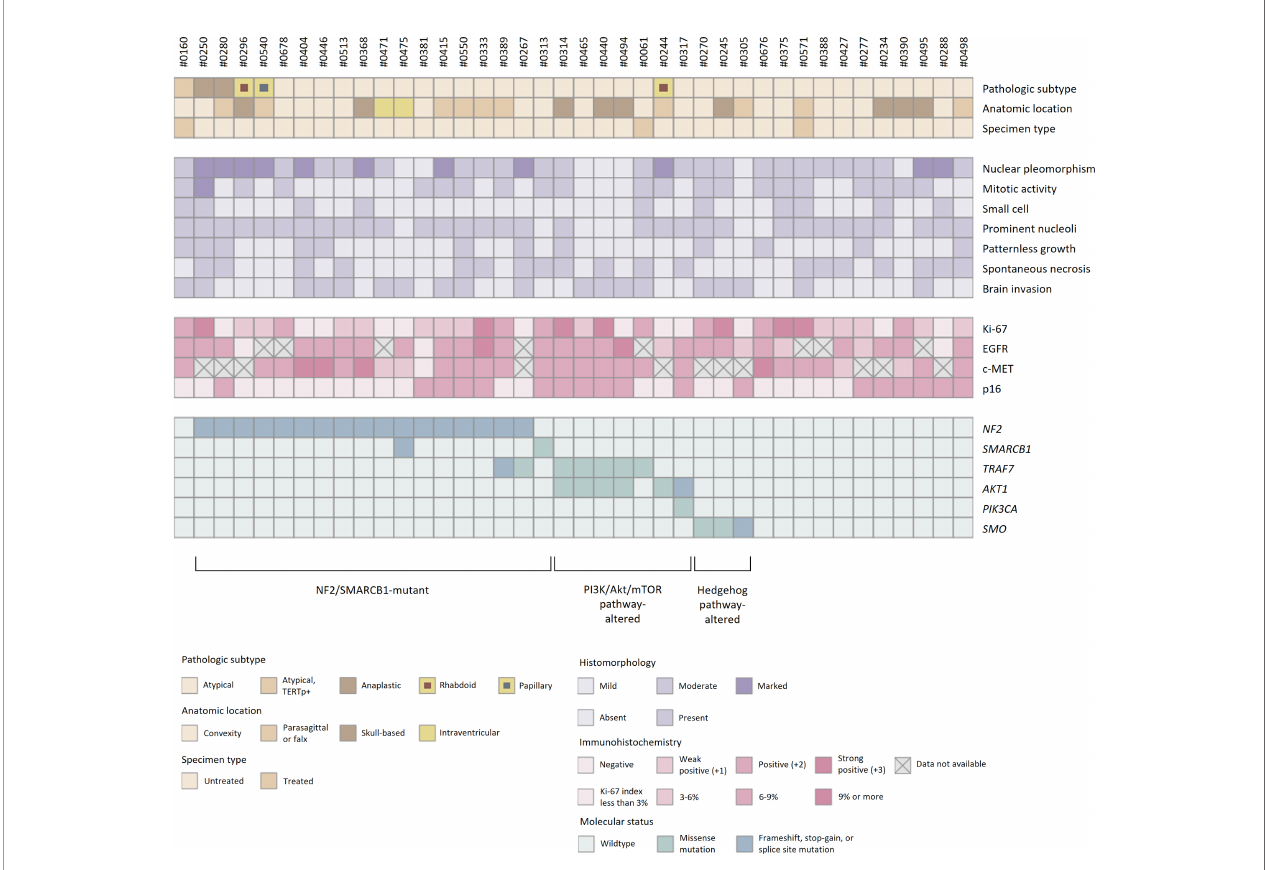
FIGURE 6 | Histopathologic features and molecular status of grade 2/3 meningiomas. Grade 2/3 meningiomas exhibited heterogeneous clinical, histopathologic, and genomic